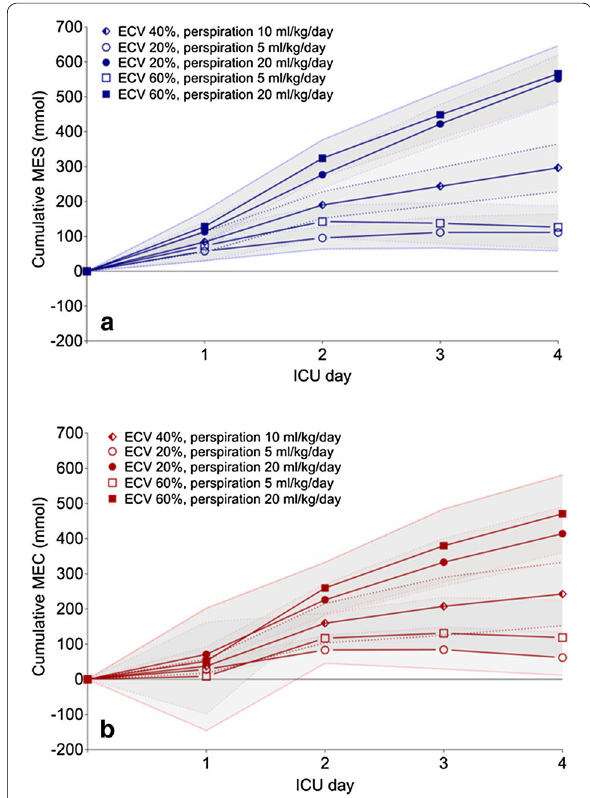
Fig. 2 Scenarios for both estimated cumulative MES and MEC. Values are depicted as mean 95% CI. The 95% CI is represented ± by the dotted lines. The first values reflect levels at ICU admission, when storage was assumed to be zero. In all scenarios, there were considerable MES and MEC after 4 days of ICU admission. a With stable sodium levels, MES is mostly influenced by altering the insensible perspiration. b MEC showed a similar pattern as MES, but was slightly more affected by the changes in the extracellular compartment than